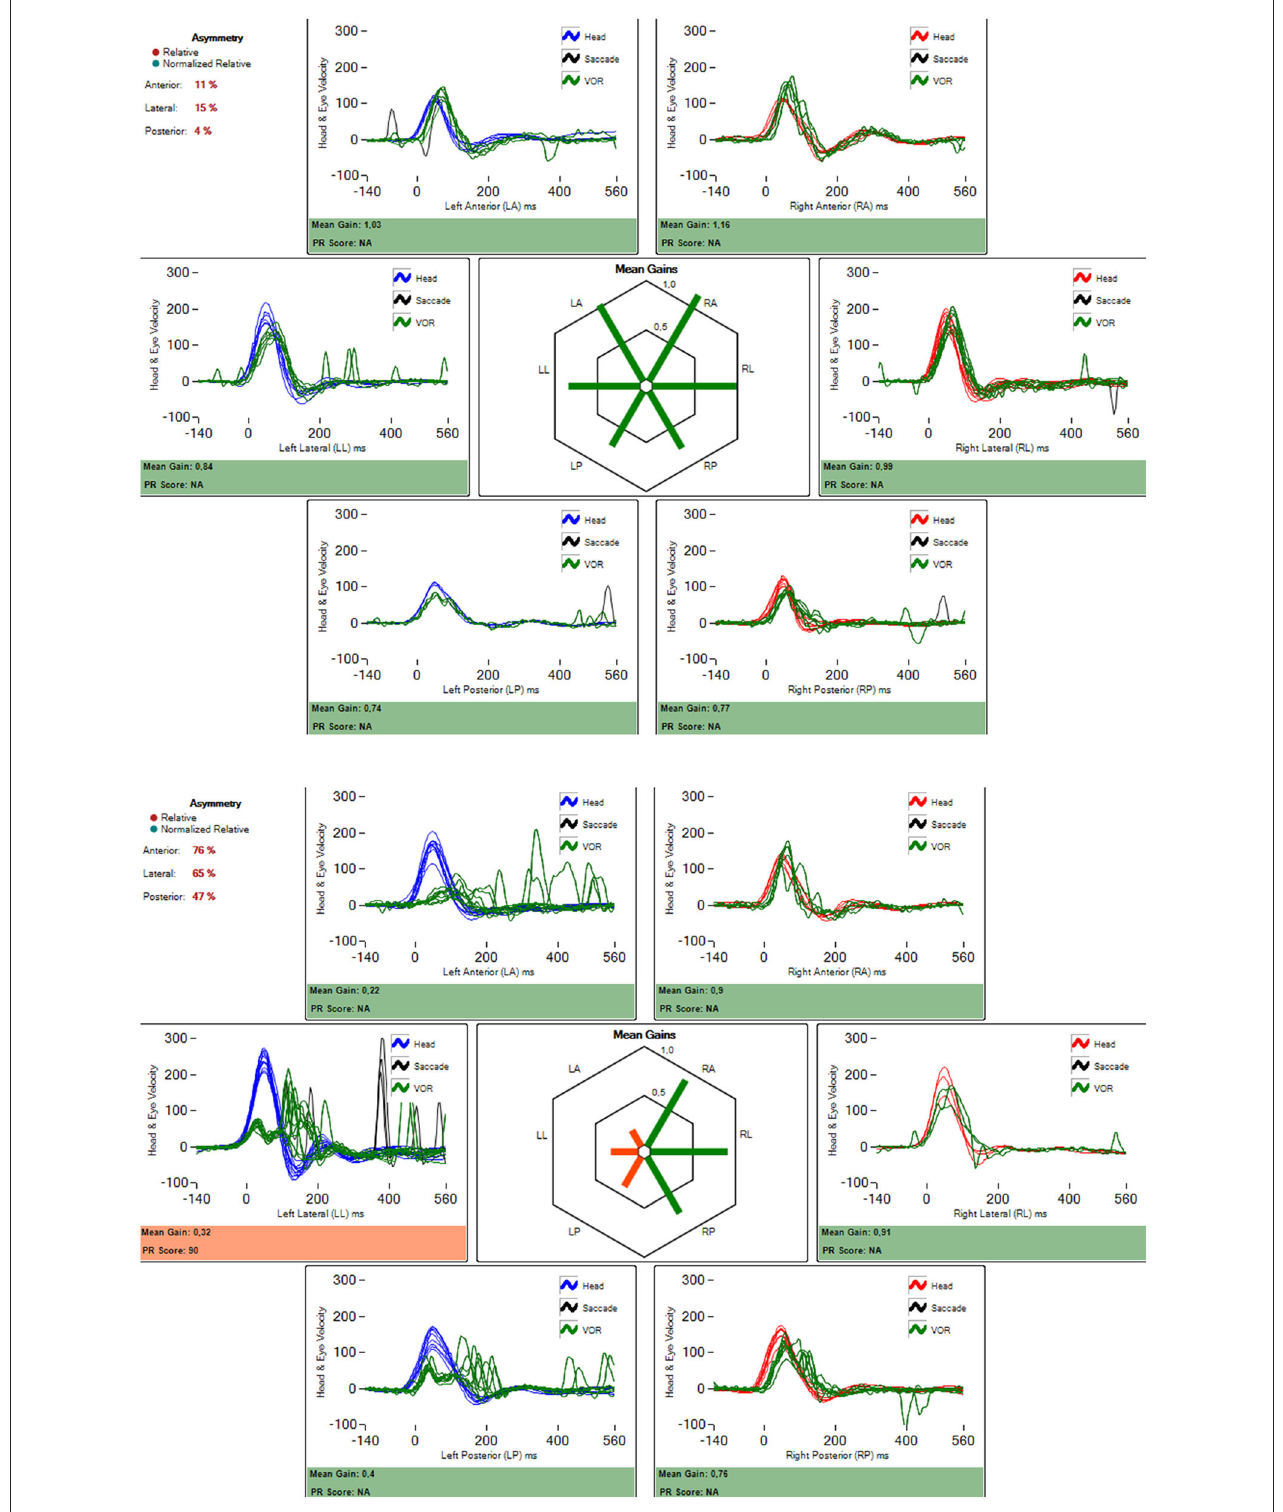
FIGURE 3 | Video head-impulse test result in a patient with left ear Ménière’s disease. In 3A before treatment with intratympanic gentamicin (1.1 ml of 27mg/ml). In 3b, 1 month after the treatment. It is an almost complete damage to all three vestibular receptors in the corresponding ampullae. The amount of gain reduction (according to formula in the material and methods section) was